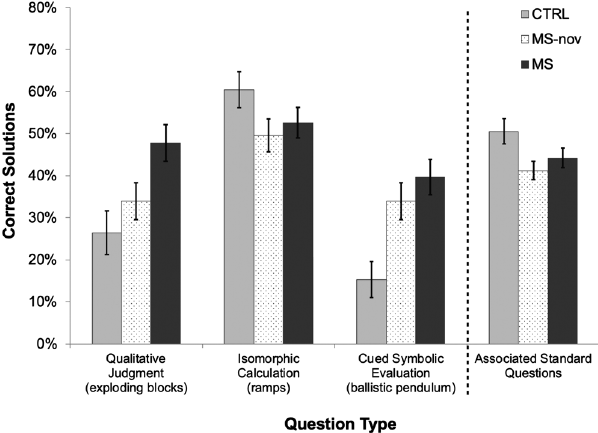
FIG. 4. Percentage of correct solutions of the three instructional groups on the three crossover assessments and the associated standard questions. Error bars represent (cid:2) 1 SEM, calculated from the binomial distribution for binary measures.